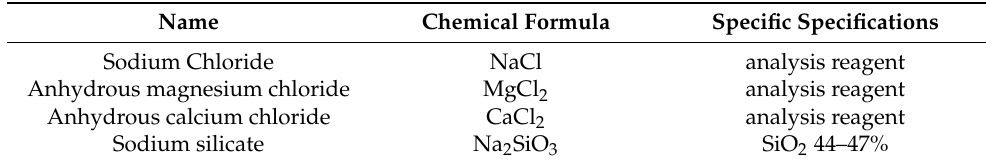
Table 1. Specifications of the chemicals used in the